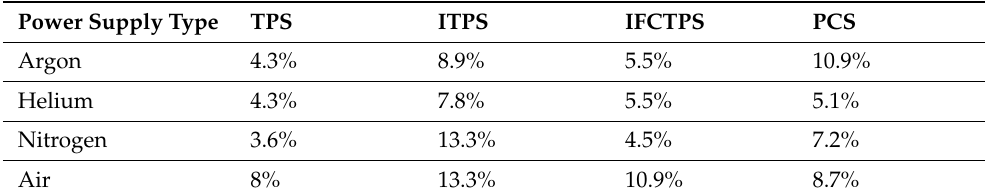
Table 6. Percentage ratio of maximum power obtained in the discharges to the power ratings of the Power